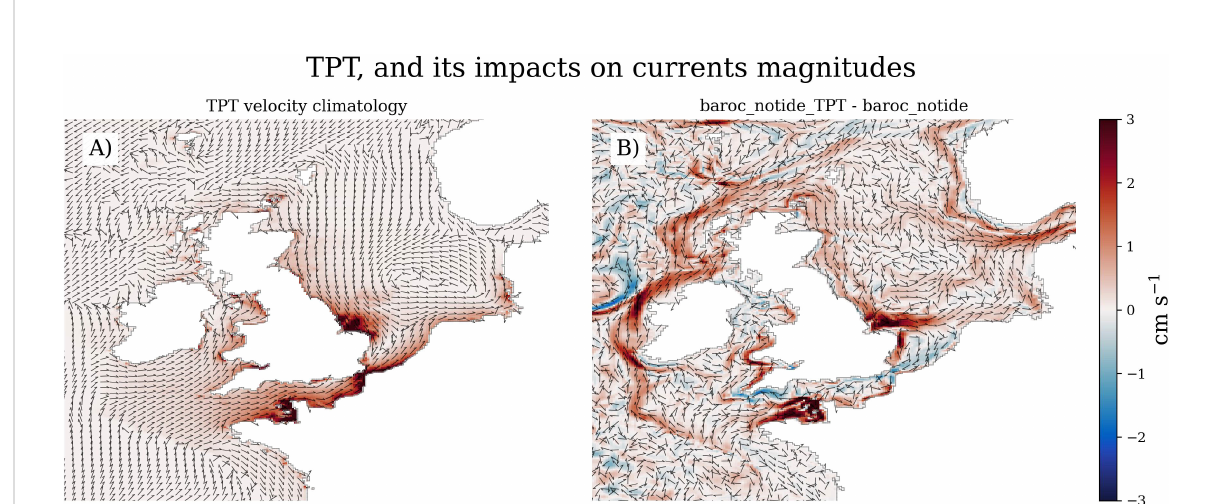
FIGURE 5 (A) Residual transport associated with TPT (cm s -1 ), and (B) the impact the TPT tidal parameterisation has on the depth-mean current magnitudes (baroc_notide_TPT-baroc_notide). The colour denotes the change in magnitude (cm s -1 ) and arrows give direction (not magnitude). Red shows where the current is faster in the tidal parameterisation simulation than in